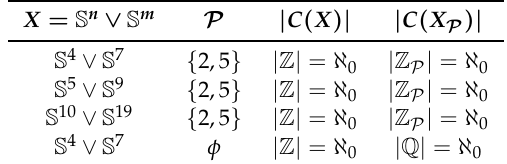
Table 4. The infinite case.